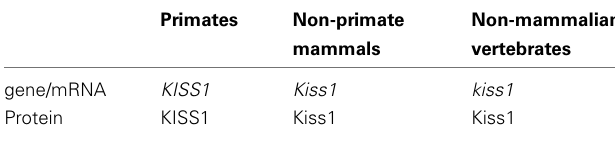
Table 1 |Terminology of gene and protein names for